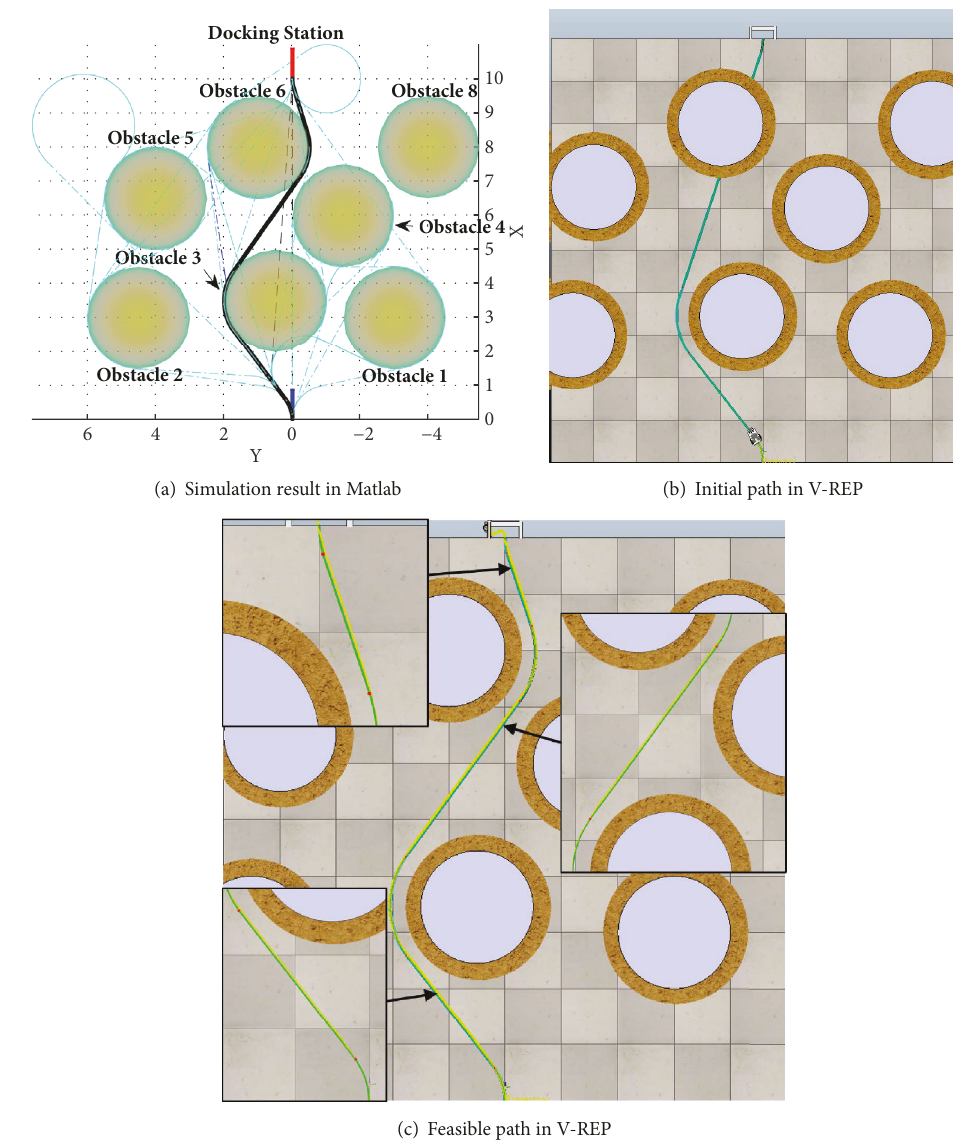
Figure 10: The path planning result of the proposed approach in scenario